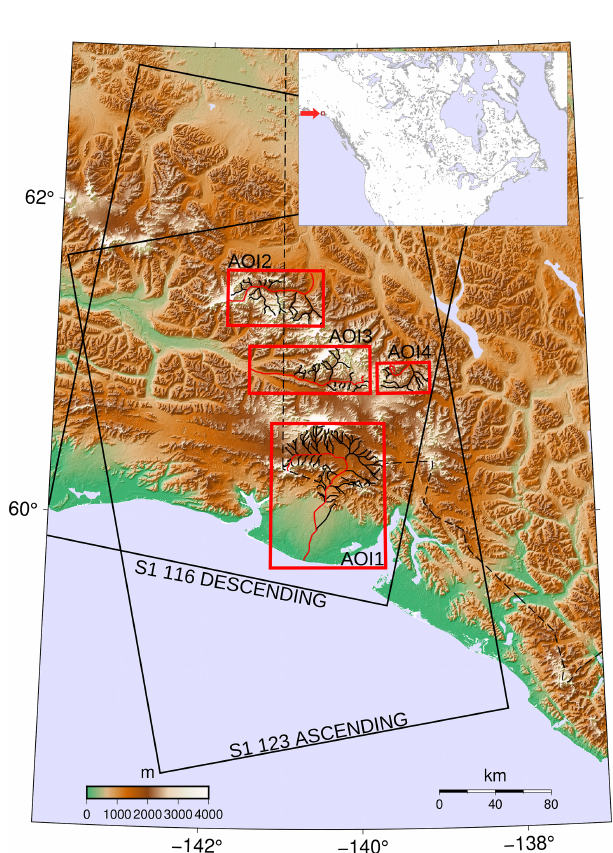
Figure 4. Outlines of four areas of interest (AOIs) in southeastern Alaska are shown in red. AOI1 covers Agassiz (AG), Malaspina (MG), and Seward (SG) glaciers. AOI2 covers Klutlan Glacier (KG). AOI3 covers Walsh Glacier (WG). AOI4 covers Kluane Glacier. Flow lines in black and red were computed using Open Global Glacier Model (OGGM) software (Maussion et al., 2019). Outlines of ascending (track 123) and descending (track 116) Sentinel-1 swaths are shown in black. The background is the 30m Advanced Spaceborne Thermal Emission and Reflection Radiome- ter (ASTER) digital elevation model (Abrams et al., 2020). The Canada–US border is shown as a dashed black line.